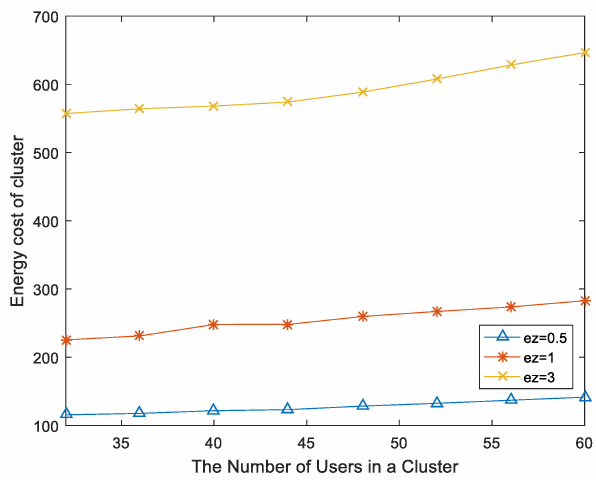
Figure 5. Energy consumption of cluster versus the number of user in a cluster ( K = 8, J = 8).